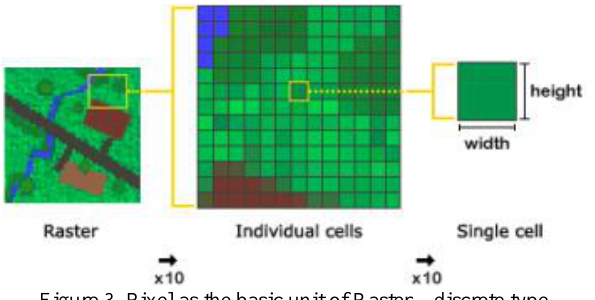
Figure 3. Pixel as the basic unit of Raster – discrete type (GICHD, 2016)